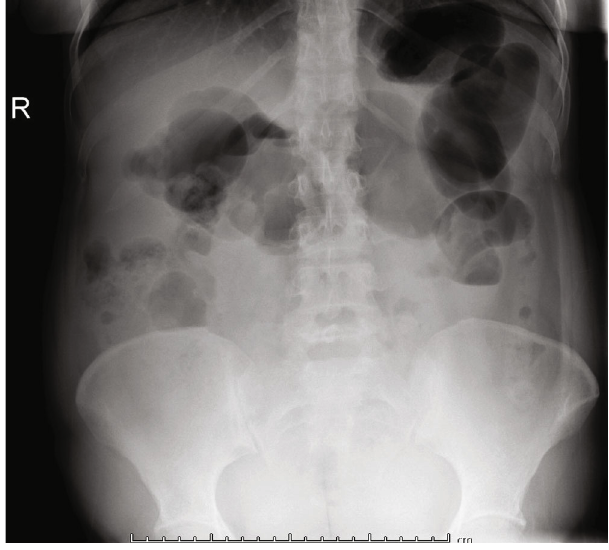
Figure 1: Image of abdominal X-ray showing mildly distended dilated gas- fi lled large bowel without gas in the rectum due to ileus or early